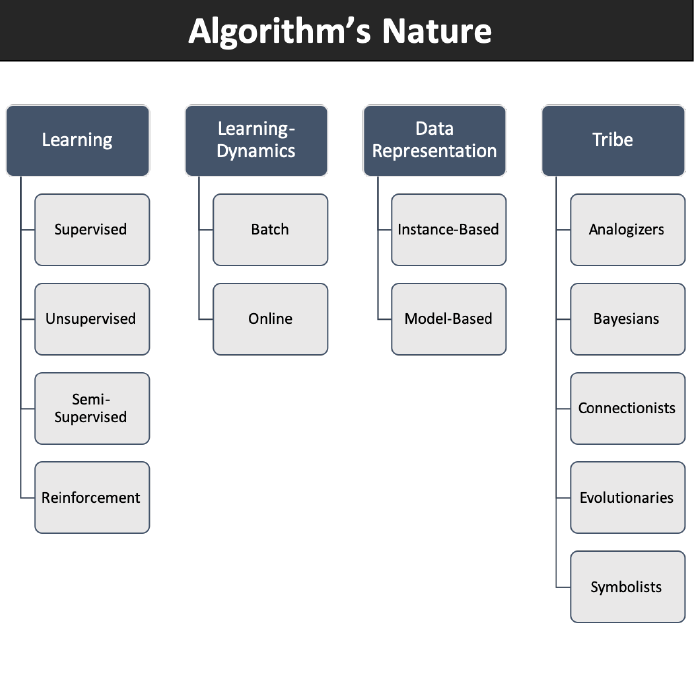
Figure 4. Algorithm’s